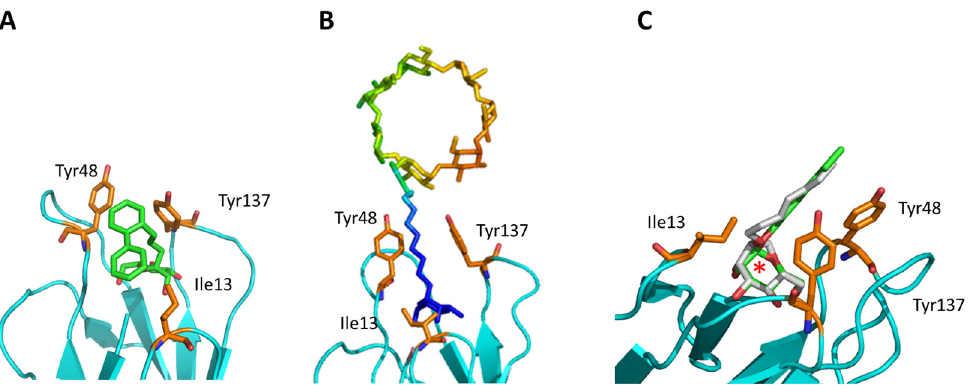
Figure 4. Recent results including the dynamics aspect of the FimH-ligand complex (formation). ( A ) A minor MD conformation (populated with 11%) shows the C117 second phenyl ring orientated towards C117 [76]. ( B ) The position of bCD in the binding pocket (PDB code: 5AB1). The ligand is colored according to the structure factor (from blue: rigid to red: highly flexible). ( C ) Comparison of the septanoside position (green; HS; PDB code: 5CGB) compared to a mannoside compound (grey; HM; PDB code: 4BUQ). The difference in the sugar ring is highlighted by a red asterisk.